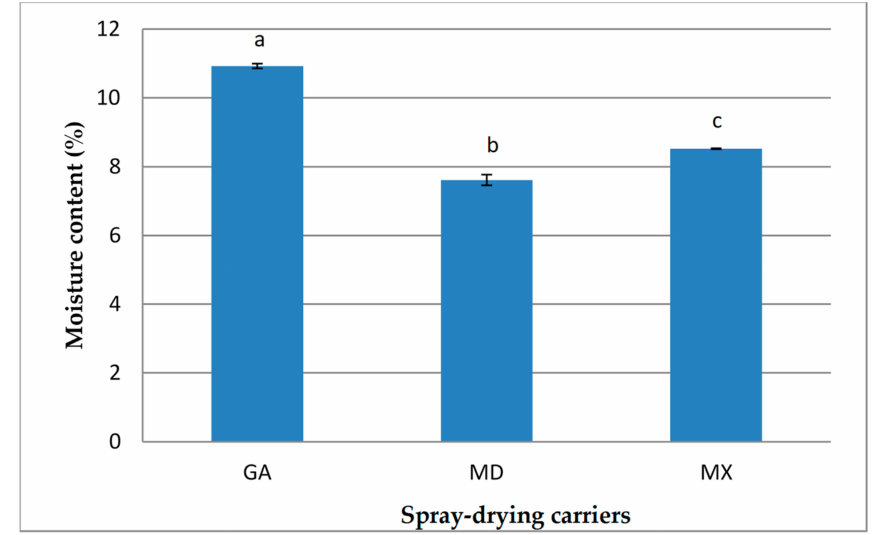
Figure 8. Moisture content (%) of different lemongrass leaf extract powders using different spray-drying carriers. All data are the mean ± SD of three replicates. Values with different letters are significantly different ( p ≤